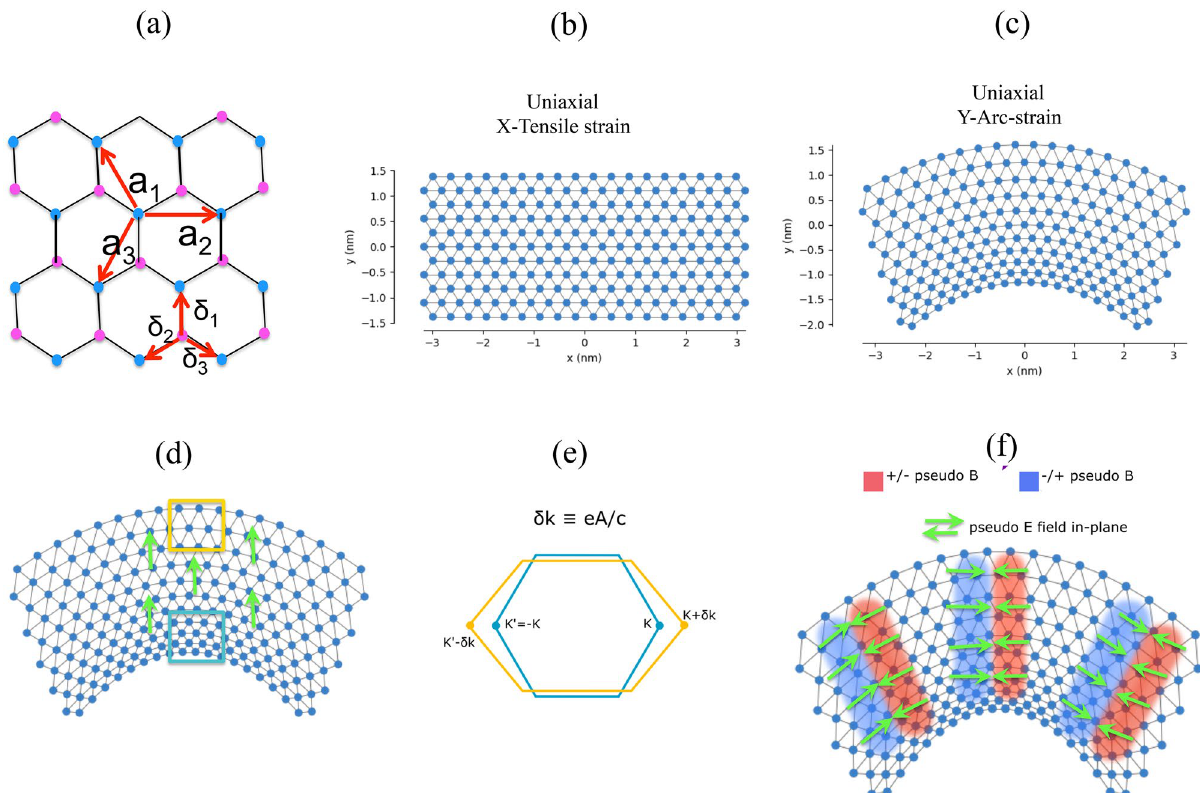
Figure 1. ( a ) Top view of unit cell of MX 2 , where δ i are the nearest neighbor and a i are the next nearest neighbors. Schematic of MX 2 nanoribbons for ( b ) X-tensile strain and ( c ) Y-arc strain. Engineering pseudo- electric/magnetic fields at strained interfaces: ( d ) High density of atoms and electrons are created by strain in regions indicated by blue box and low density of atoms indicated by yellow box, which inhomogeneous charge distribution generates an electric field (green arrows). ( e ) Yellow hexagonal shows the stretching of bonds results in shift in Dirac cones at K and K ′ points from their unstrained positions (blue hexagonal) in the reciprocal space. This momentum shift δk introduced a pseudovector potential term eA/c, which creates opposite sign pseudomagnetic fields at the two valleys. ( f ) The strain associated with pseudofields both electric fields (green arrows) and magnetic fields, where two blue/red regions indicate the ± z ̂ direction of pseudospin up and down.